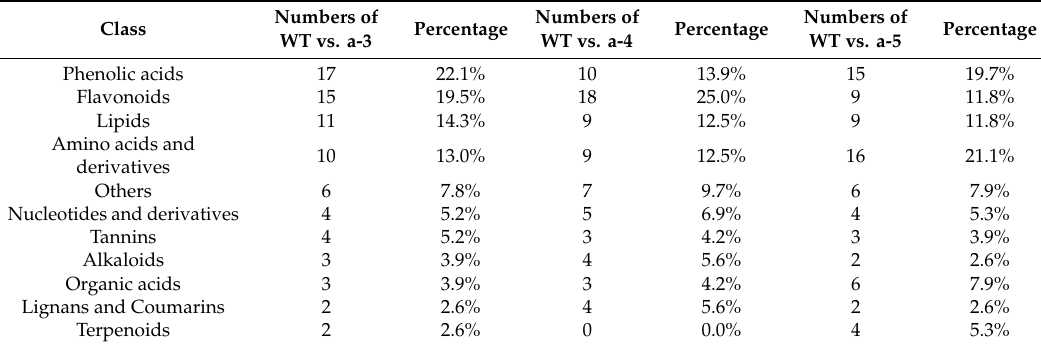
Table 2. Numbers of DAMs class among groups.